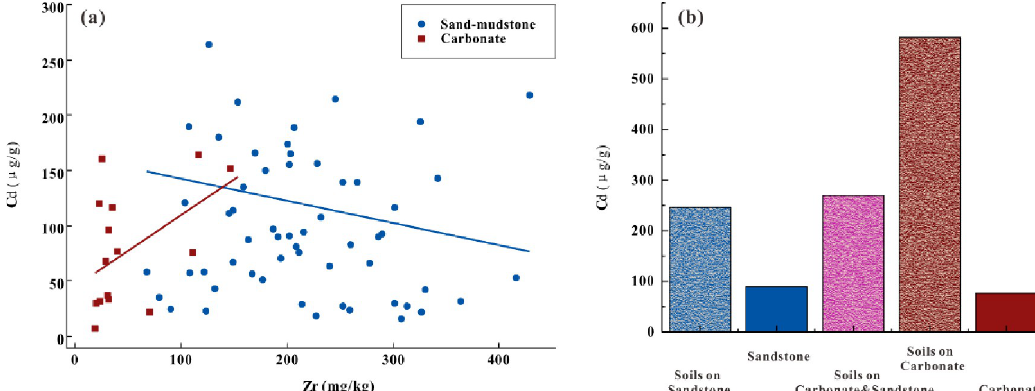
Fig 4. a: Concentrations of Cd and Zr in different rocks and soils; b: median Cd.